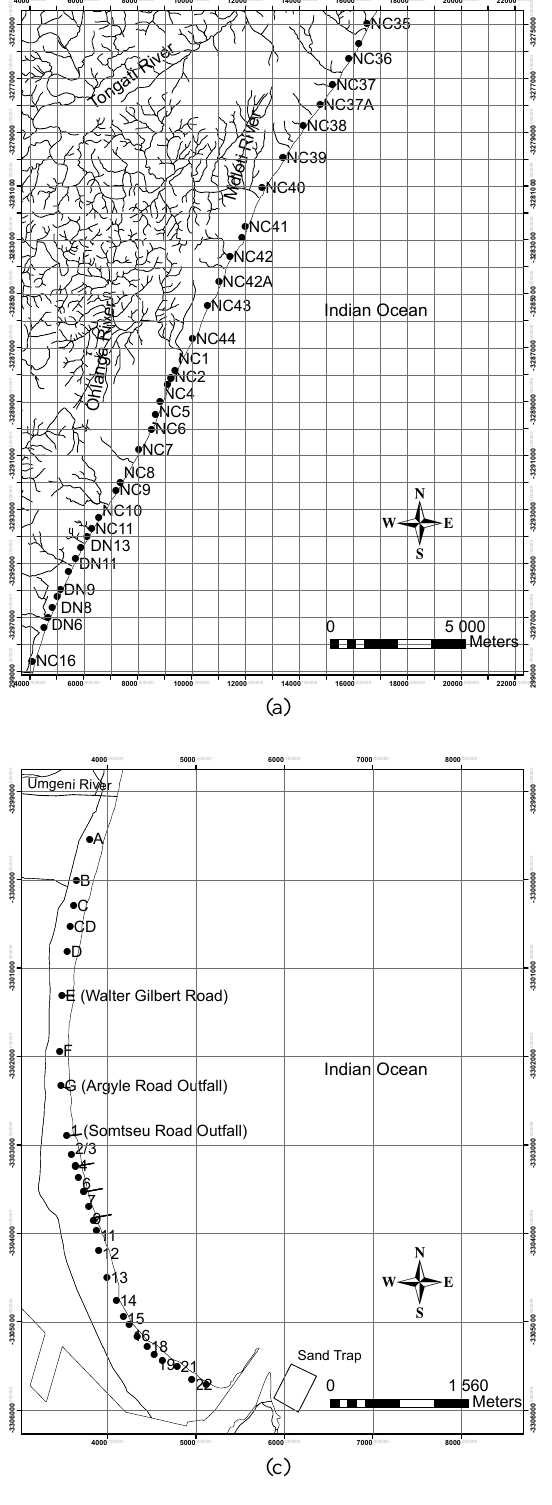
Fig. 2. Locations of beach profiles and rivers. Coordinate system: Lo 31 – WGS84. (a) From DN6 to DN13 of Durban North and from NC16 to NC35 of the North Coast (b) From SB1 to BR13 of the Durban Bluff (c) From A to 23 of the Durban Bight and the sand trap (d) From SC11 to SC42 of the South